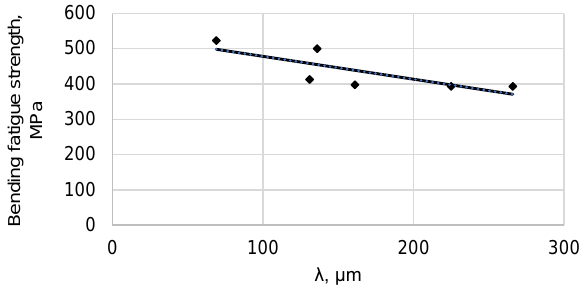
Figure 1: Bending fatigue strength of steel hardened and tempered at 200 ∘ C subject to impurities space